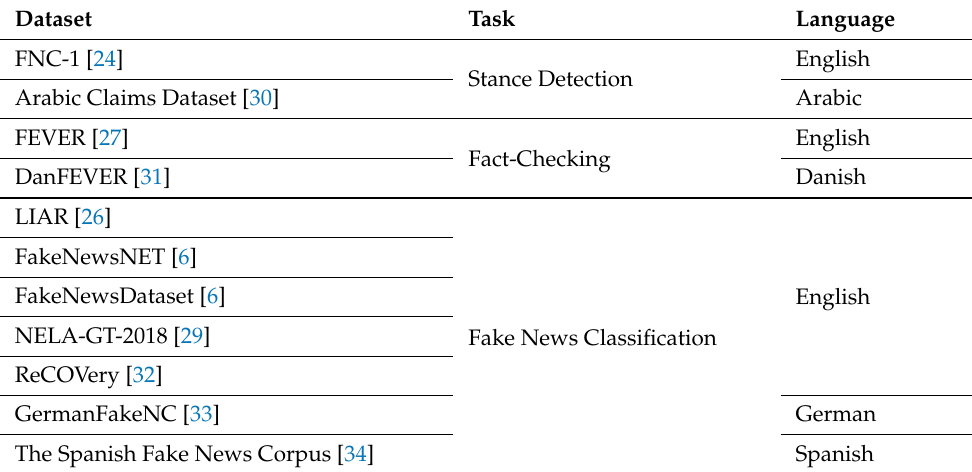
Table 1. The datasets covered in related work. The majority of datasets for fake news detection tasks are in